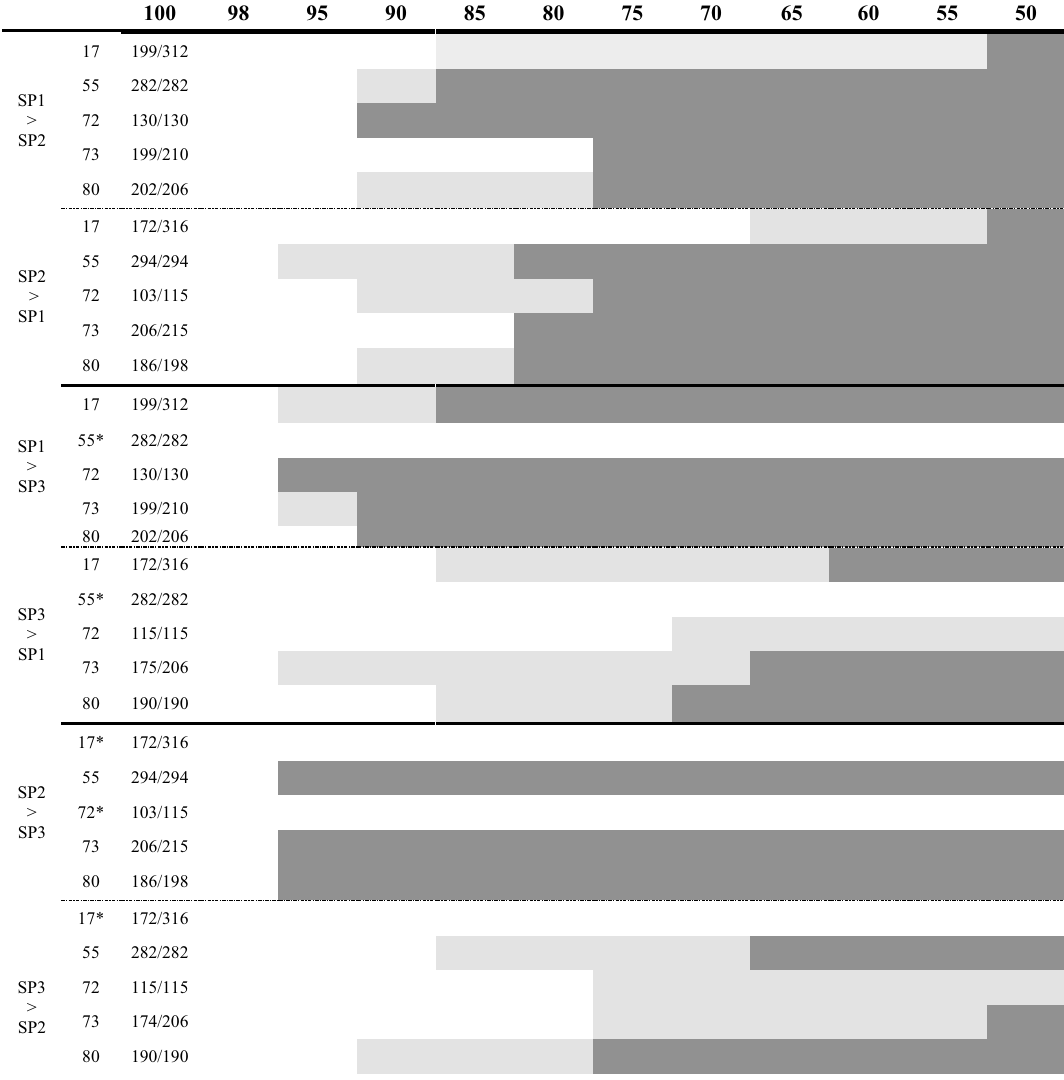
Table 1. Stylophora pistillata ‘artificial chimeras:’ genet profiles and the detection thresholds of microsatellite loci. All possible pairwise combinations (Pair) of DNA mixtures of three S. pistillata genotypes (SP1, SP2, SP3), presented from 100% of the abundant genotype/0% second genotype to 50%/50% genotypic concentration ratio. Five microsatellites (STR, Stylo_n) are presented, with microsatellite allele sizes (bp) appearing in the 100% column. Dark-grey areas highlight DNA ratios where both genotypes were clearly detected by a specific microsatellite; light-grey areas highlight DNA ratios where the least common genotype was elucidated in